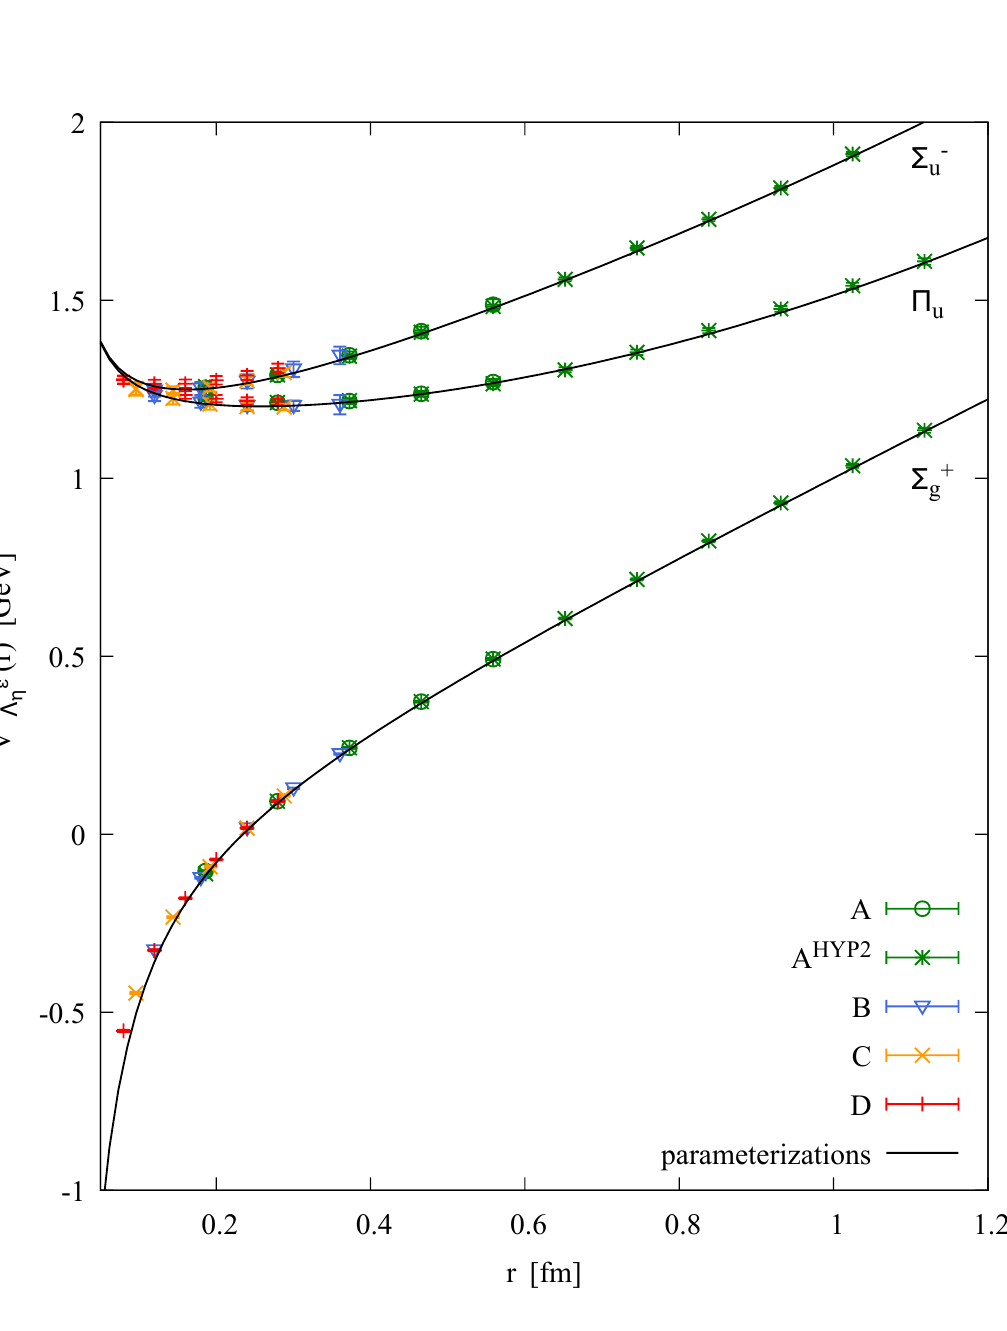
and Σ − hybrid static u u